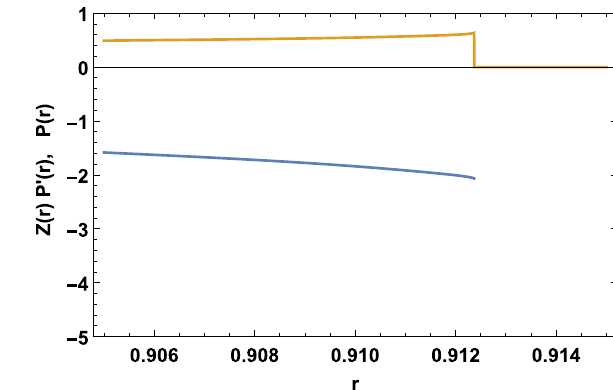
Fig. 9 The Z ( r ) function (after being multiplied by a constant) for the polytropic gas system, which defines r b as the radius when it reaches the zero value In fact the polytropic gas also shows solutions in which the gas is rigorously confined within a spherical region of radius r b .